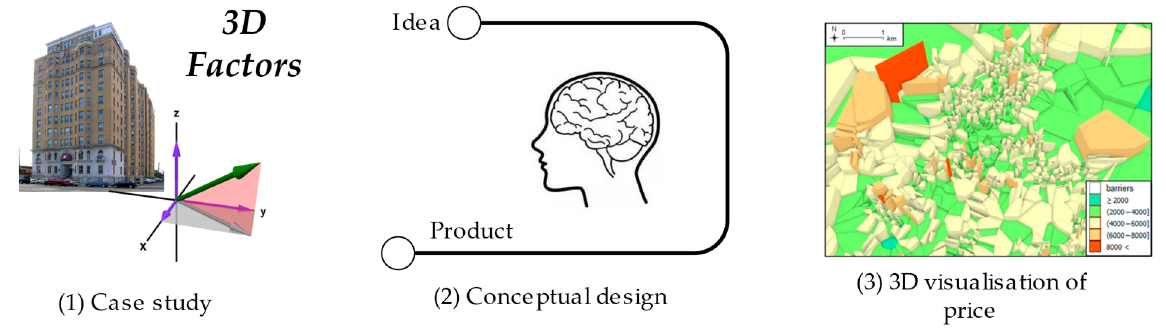
Figure 2. Different research types in 3DPV